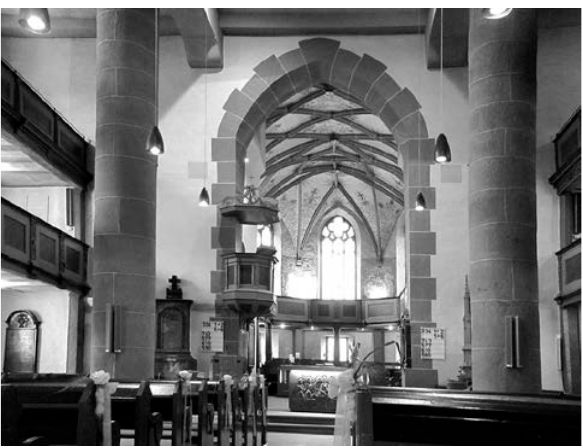
Figure 2: Evangelic Town Church